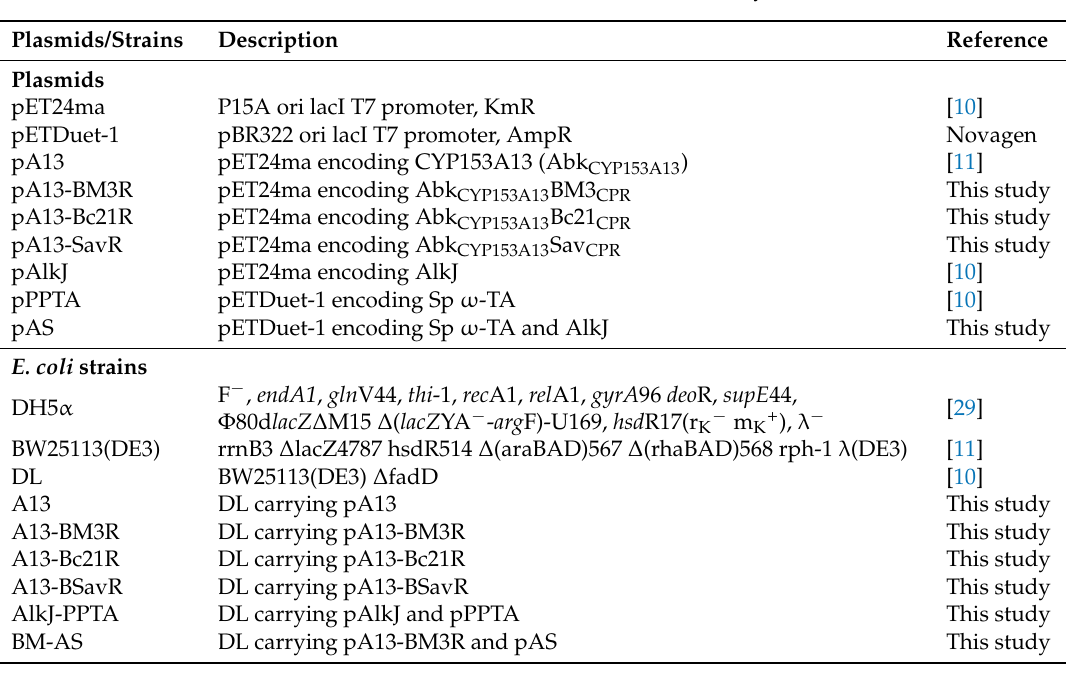
Table 1. Plasmids and strains used in this